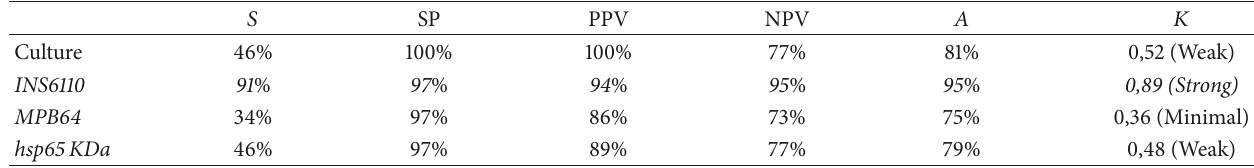
Table 4: Culture and real time PCR results for 100 samples included on the study.